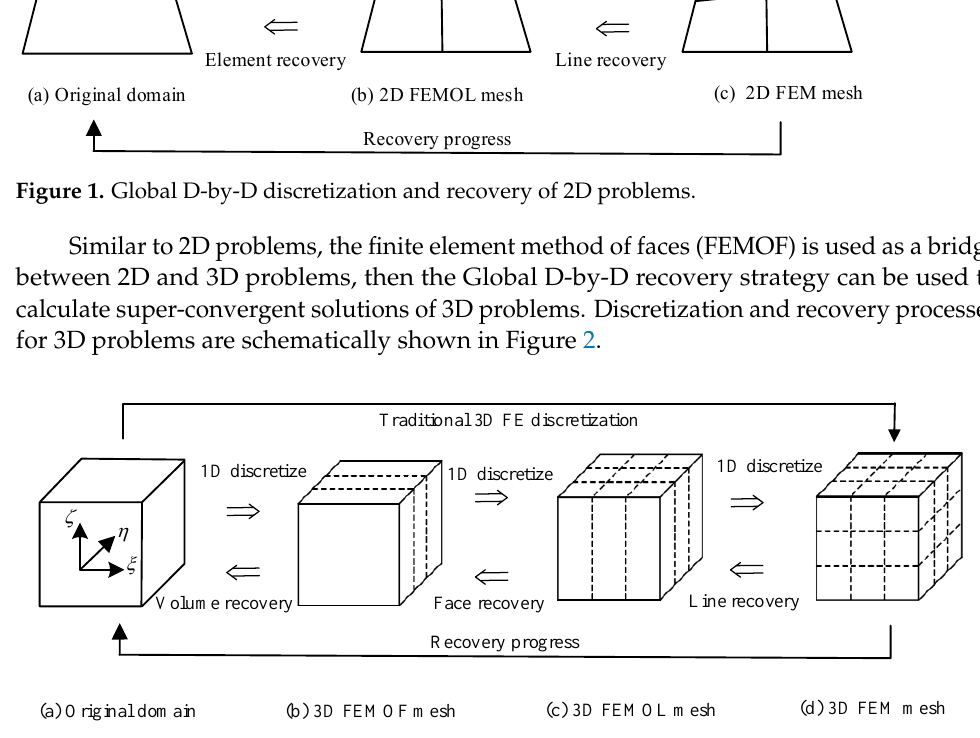
Figure 2. Global D-by-D discretization and recovery of 3D problems.